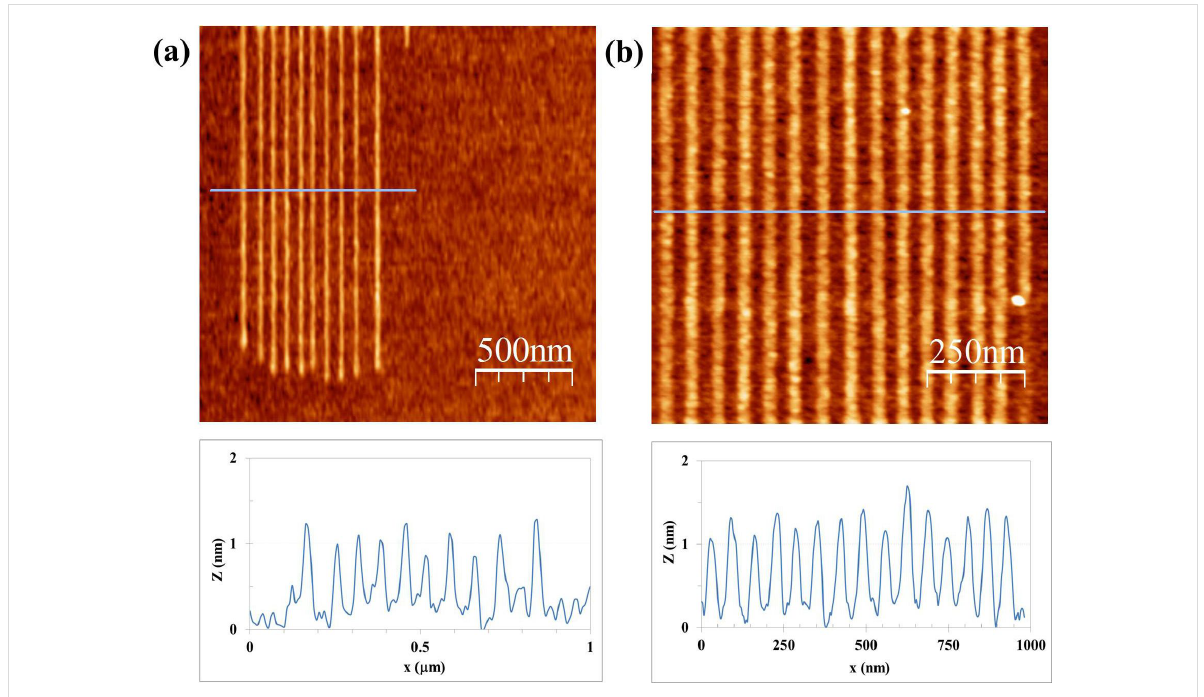
Figure 5: Reproducibility for patterning line arrays by using CNF probes. Array of lines written at a) 23.4 V and b) 43.2 V, having line height of ca. 0.8 nm and ca. 1.2 nm, respectively. The common writing speed is 4 μ m/s, RH is 30%.